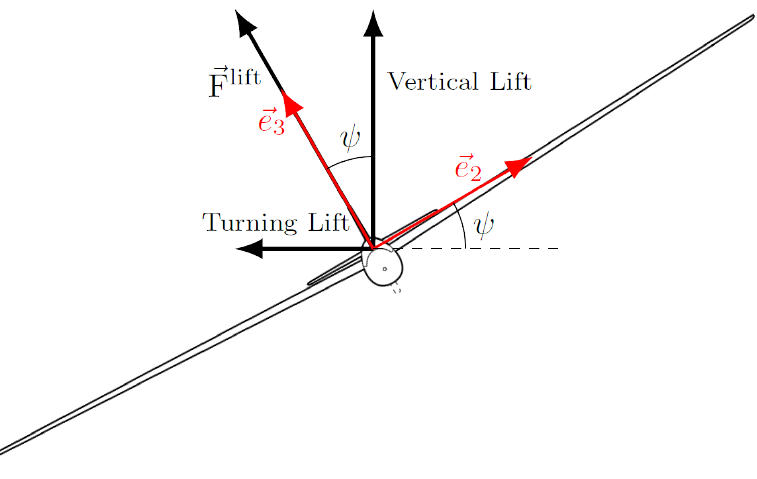
Figure 2. Roll angle and turning dynamics.